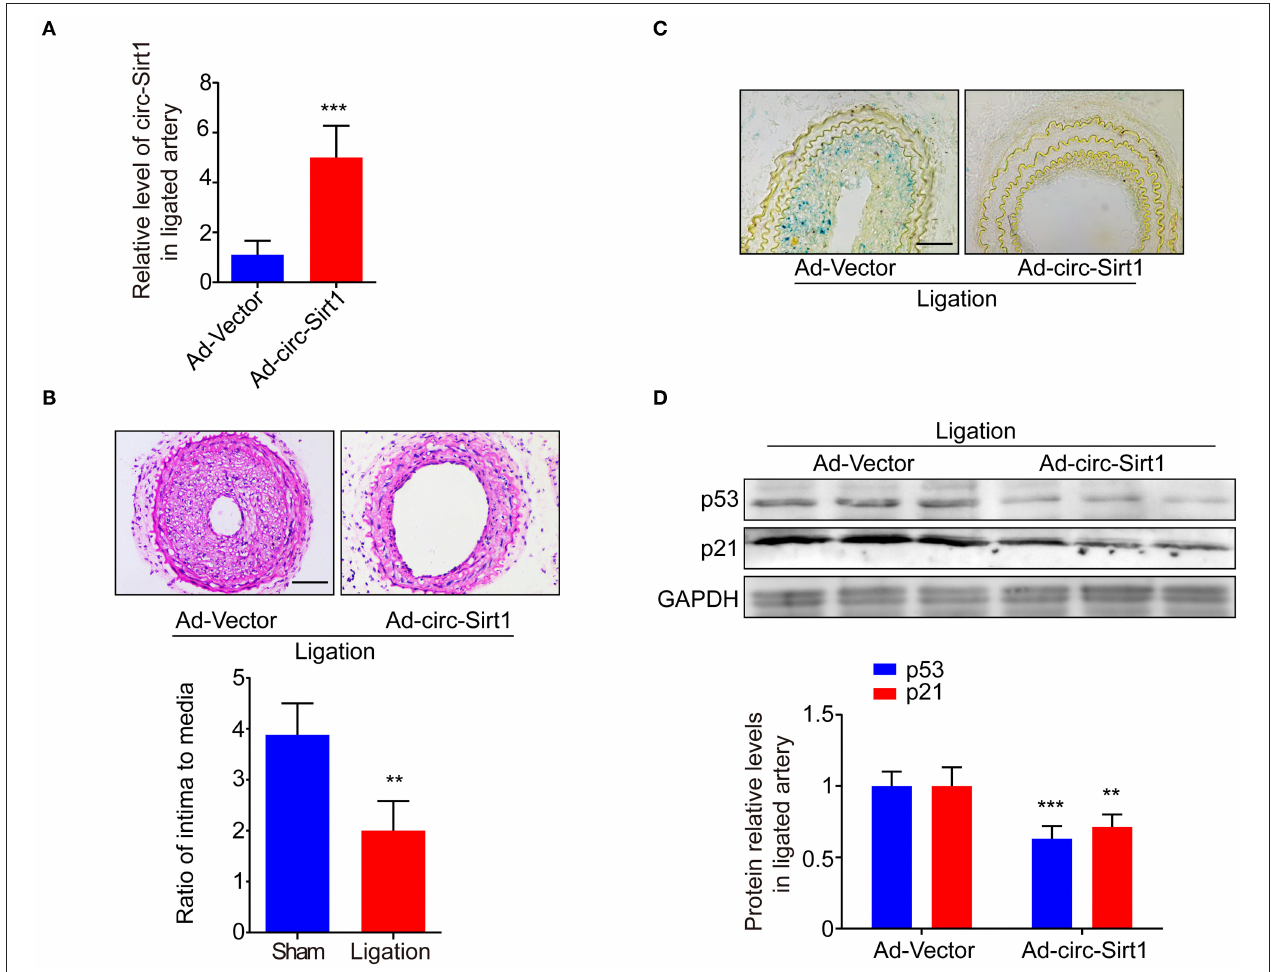
FIGURE 5 | Overexpression of circ-sirt1 inhibits senescence-related neointimal hyperplasia in vivo . (A) qRT-PCRs for circ-Sirt1 in Ad-Vector or Ad-circ-Sirt1-infected carotid arteries at 14 days after ligation. (B) Representative hematoxylin and eosin-stained arterial sections from Ad-Vector or Ad-circ-Sirt1-infected carotid arteries at 14 days after ligation. Scale bar = 100 µ M. The ratio of intima to media (I/M). (C) Representative senescence-associated β -galactosidase (SA- β -gal) staining. Scale bar = 50 µ m. (D) Western blot for p53 and p21. Bar graphs represent the mean ± SD and were analyzed with Student’s T -tests. ** p < 0.01, *** p < 0.001 vs. Ad-Vector group. n = 5/group for (A,B,D)